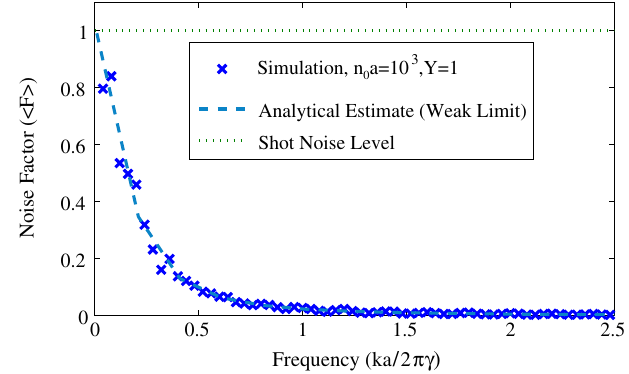
FIG. 6. A comparison of simulation and analytical results shows noise suppression as a function of frequency. With (cid:2) (cid:6) 1 at high frequency, we find strong suppression. At low frequencies ( k & 2 (cid:3)=a ), we no longer have ~ h u ð k Þ / 1 =k , so suppression is weaker for the given